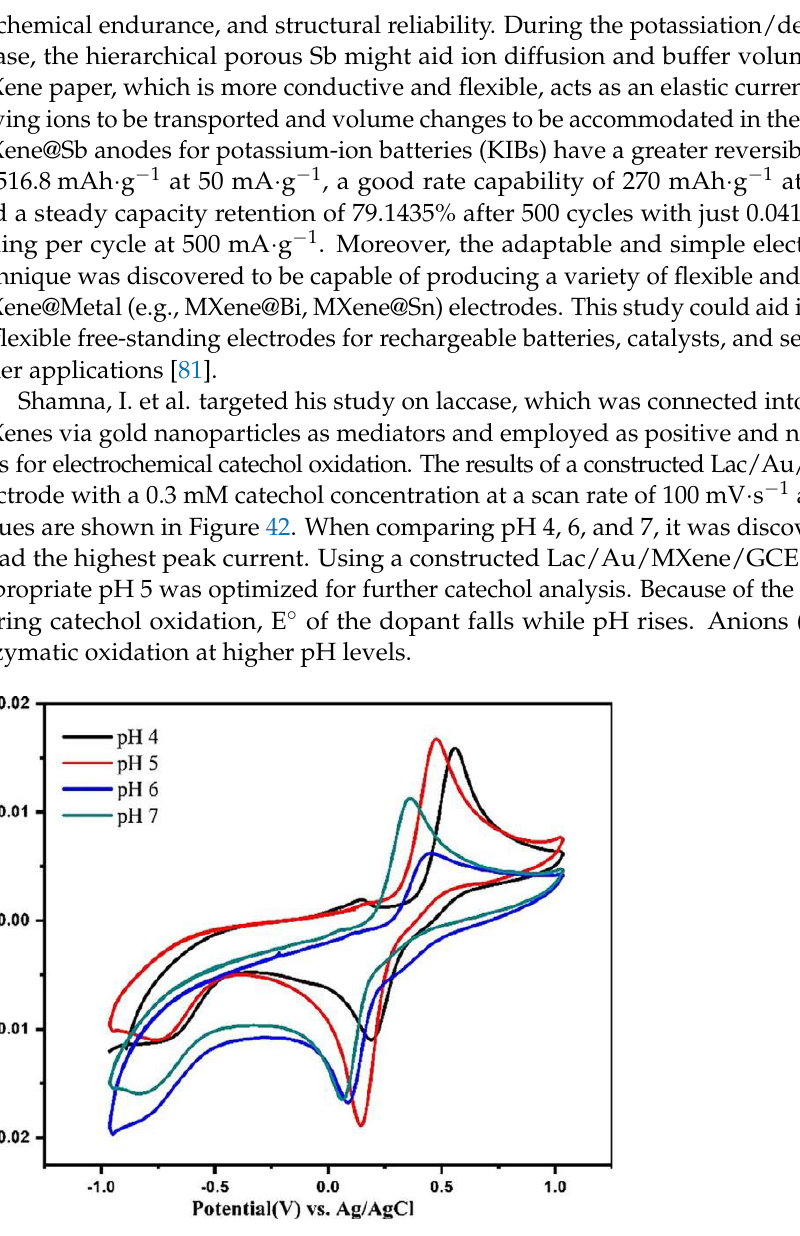
Figure 42. Cyclic voltammetry response of Lac/Au/MXene/GCE for 0.3 mM catechol